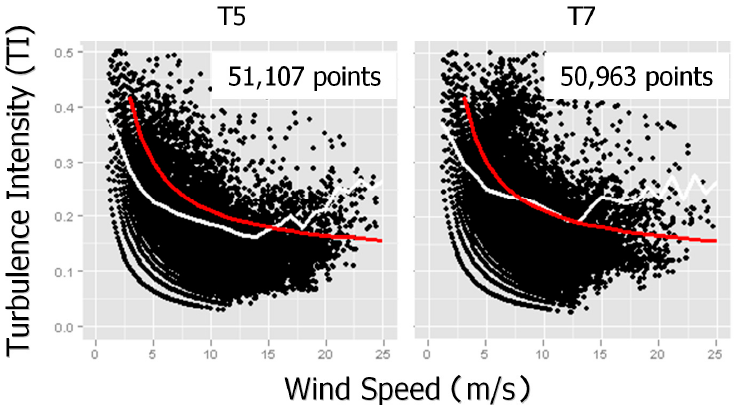
Figure 4. Comparison between the turbulence intensity (TI) at wind turbine #5 (T5) and that at T7. The data plotted here are those that were collected during the first year of the wind turbine operation. The numbers in the upper right indicate the number of plotted data values. The red lines indicate the relationship between TI and wind speed for International Electrotechnical Commission (IEC) turbulence class A. The white lines indicate the sum of the bin average and one bin standard deviation ( σ ) of the plotted TI values.